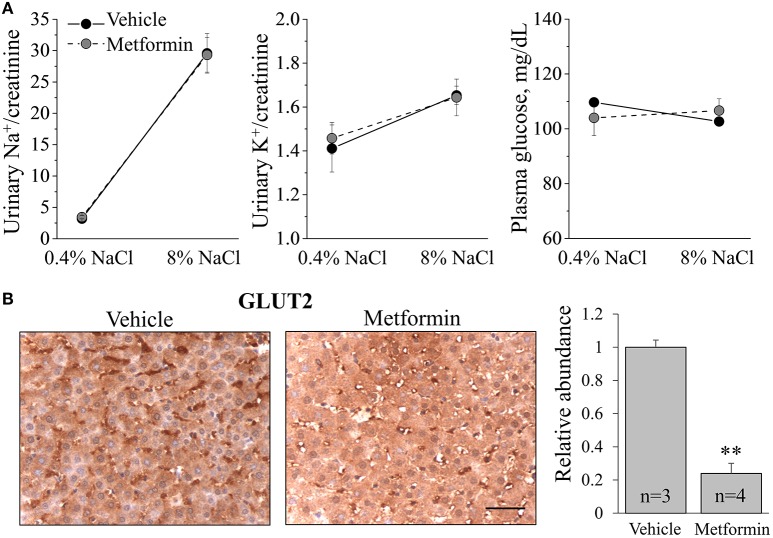
Metformin treatment reduces Glut2 expression in the liver. (A) Urinary sodium and potassium excretion and plasma glucose levels in vehicle- and metformin-treated rats. (B) Immunohistochemical staining demonstrates that metformin treatment decreases abundance of hepatic Glut2, a key glucose transporter involved in glucose release (40x). Scale bar = 50 μm. Shown on the right is summary graph for Glut2 relative abundance (**p < 0.01 relative to vehicle).